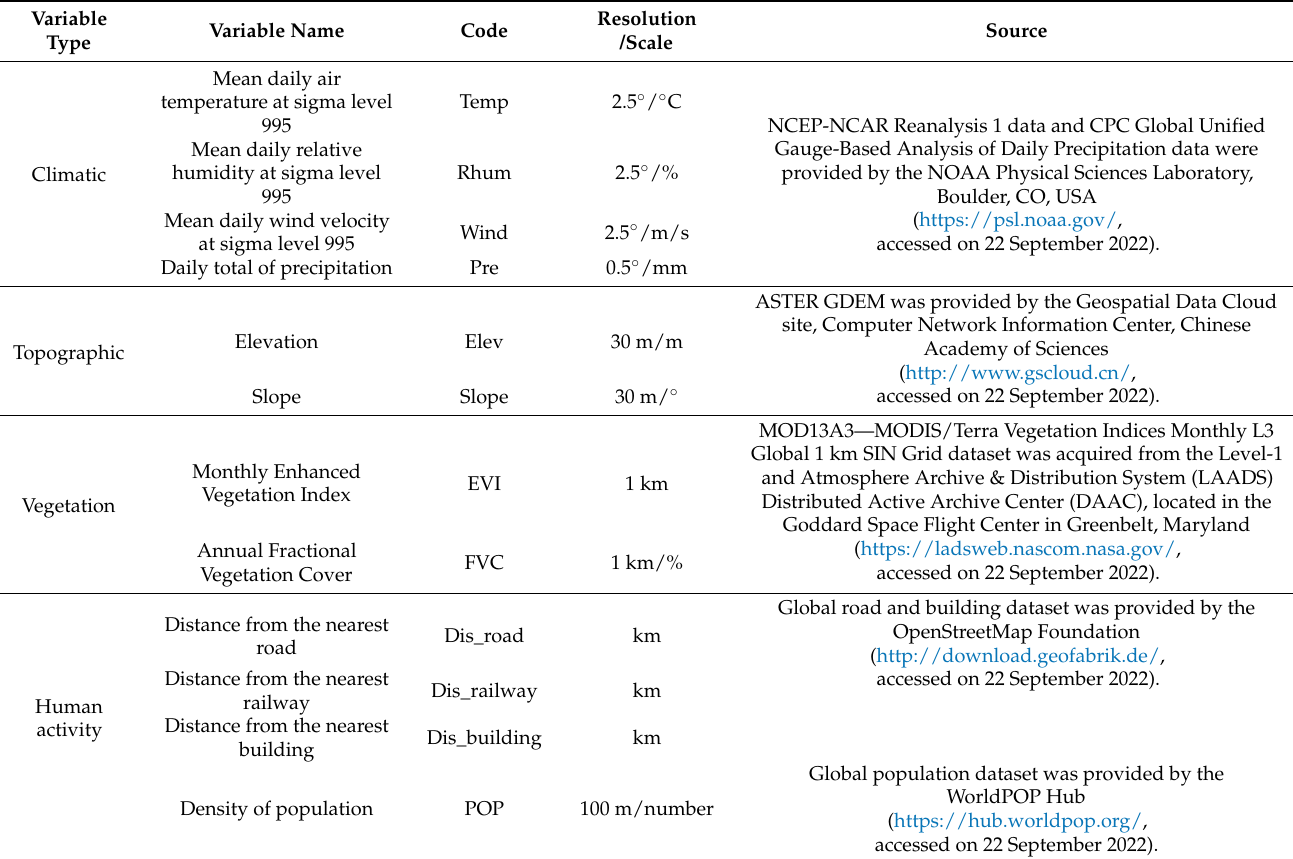
Table 2. Overview of independent variables used in the construction of forest fire prediction